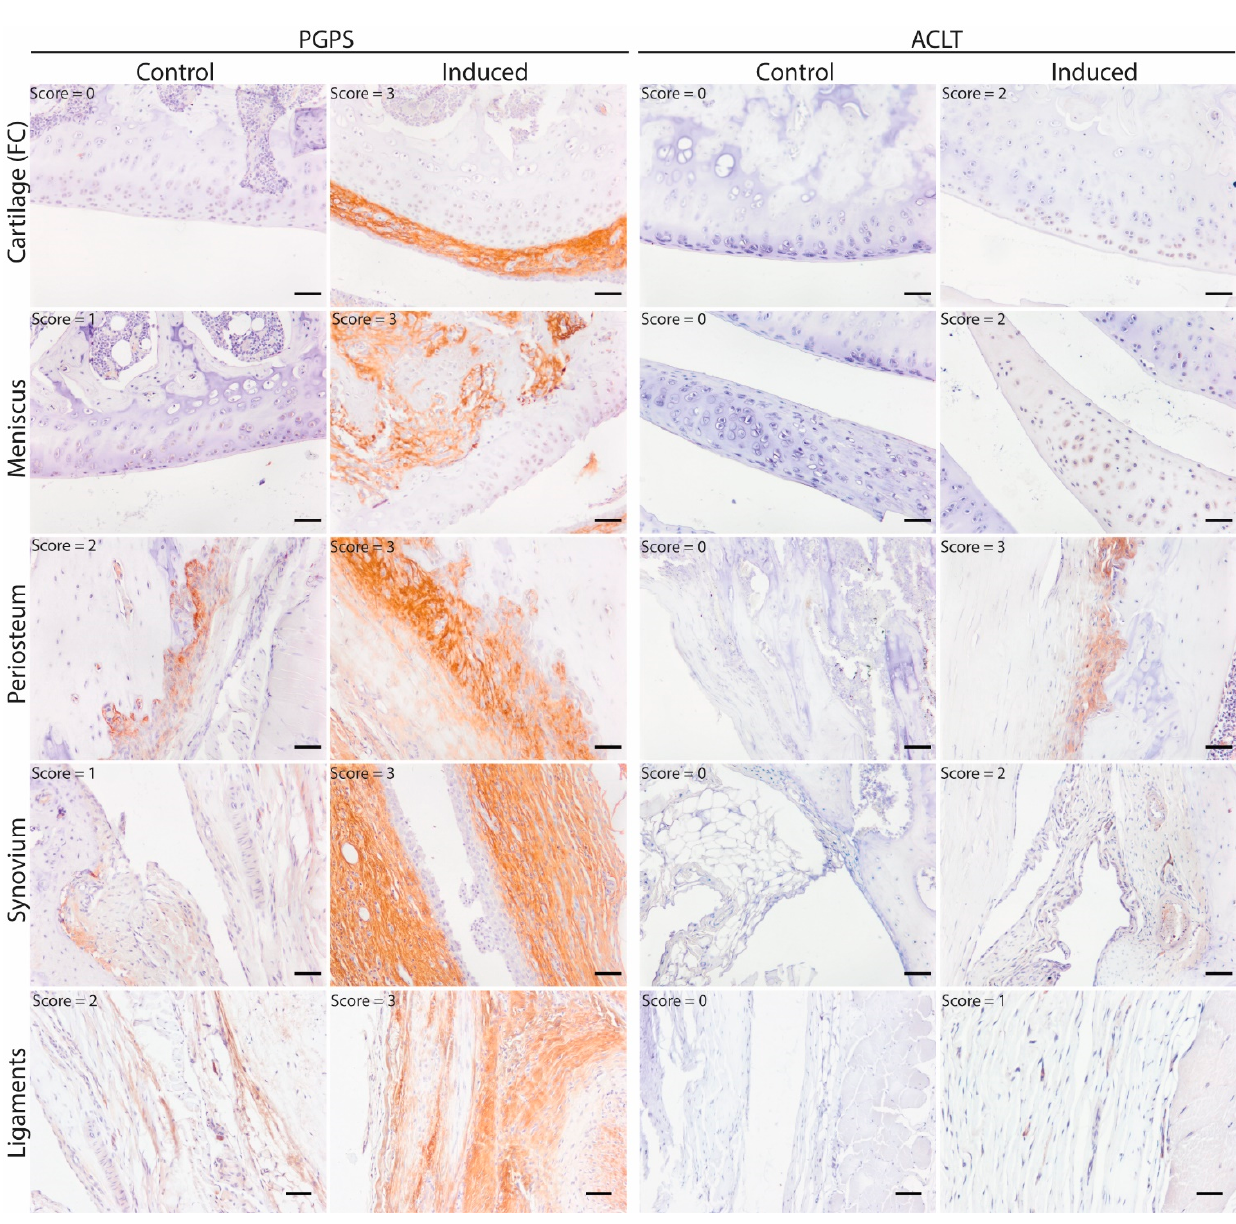
Figure 1. OSM expression pattern in acute arthritis and instability-induced OA. Representative pictures of OSM expression (brown staining) in different joint structures: Femur condyle (FC) cartilage (chondrocytes), meniscus, periosteum and synovium. Acute arthritis in the PGPS model was induced by intra-articular injection of PGPS in the left knee. The ACLT model was induced unilaterally (left knee) through anterior cruciate ligament transection and partial medial meniscectomy. Individual scores for each structure are displayed in the top left corner of each picture. Scale bar: 50 µ